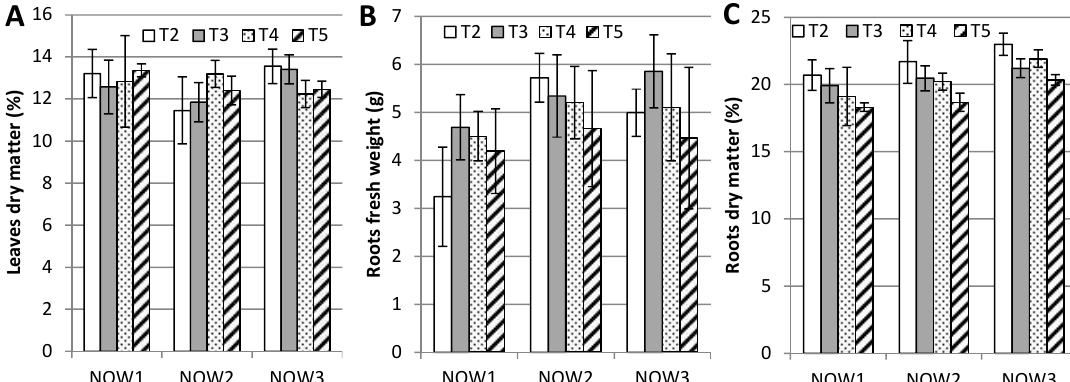
Figure 5. Different effects of 6-benzylamino purine (BAP) treatments on weight traits and dry matter of harvested offshoots from nursery plants according to their size: ( A ) leaves dry matter, ( B ) roots fresh weight and ( C ) roots dry matter. Standard errors are reported. T2: BAP 0 ppm + cut-back; T3: BAP 100 ppm + cut-back; T4: BAP 200 ppm + cut-back; T5: BAP 300 ppm + cut-back; NOW1: nursery offshoot fresh weight < 30 g; NOW2: 30 g ≤ nursery offshoot fresh weight ≤ 60 g; NOW3: nursery offshoot fresh weight > 60 g.